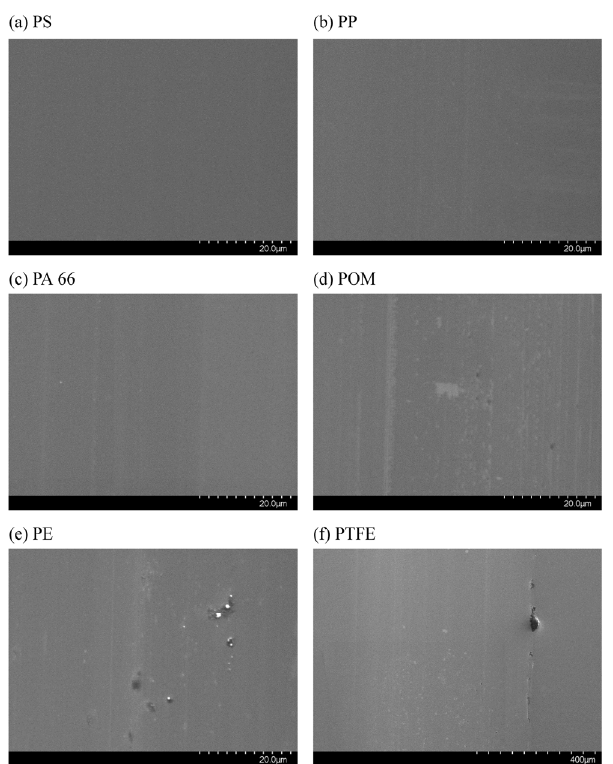
Fig. 6 Morphology of the silicon surface after friction with different polymer spheres in the vertical contact mode. (a) PS; (b) PP; (c) PA 66; (d) POM; (e) PE; and (f) PTFE.